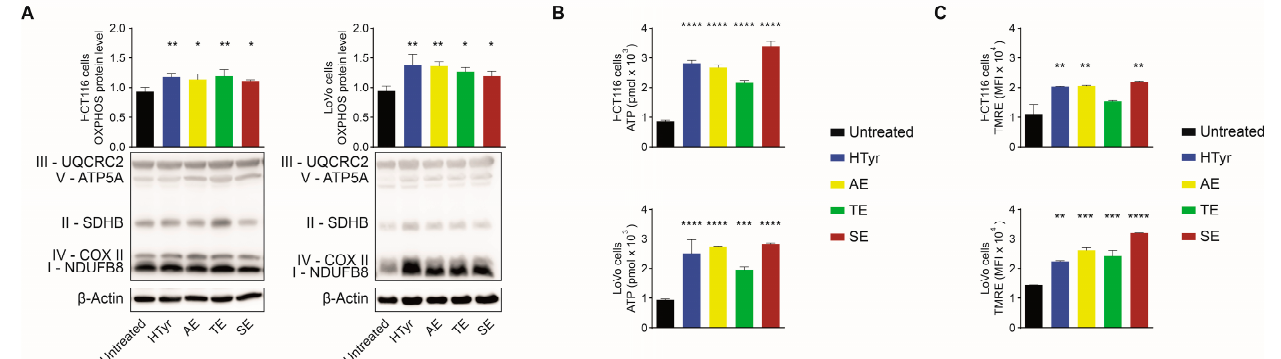
Figure 2. HTyr and OPWPs extracts affect mitochondrial functions. ( A ) Representative immunoblots of lysates of HCT116 and LoVo cells untreated or treated with HTyr or OPWPs extracts for 72 h for assessing the proteins ATP5A, UQCRC2, SDHB, COX II, and NDUFB8 belonging to the respiratory chain complexes V, III, II, IV, and I, respectively. The histograms report the overall OXPHOS protein quantification normalized to β -Actin or α -Tubulin, used as loading controls, and show the mean ± SD of three independent experiments. ( B ) ATP levels measured in HCT116 and LoVo cells treated as in ( A ) and expressed as picomoles (pmol). ( C ) Flow cytometry analysis of the cells treated as in ( A ) and stained with TMRE to evaluate the mitochondrial membrane potential calculated as Median Fluorescence Intensity (MFI) of two independent experiments. Statistical significance was considered when * p < 0.05, ** p < 0.01, *** p < 0.001, or **** p < 0.0001 (ANOVA with Dunnett’s post-test).